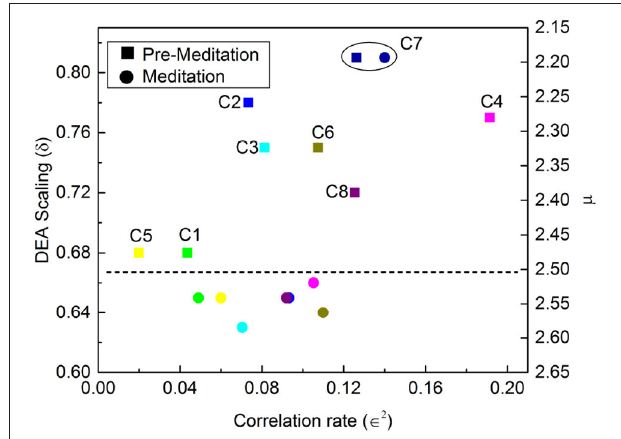
FIGURE 7 | DEA scaling δ , IPL index µ and ∈ 2 of the HRV time series of eight different participants before and during Chi meditation.